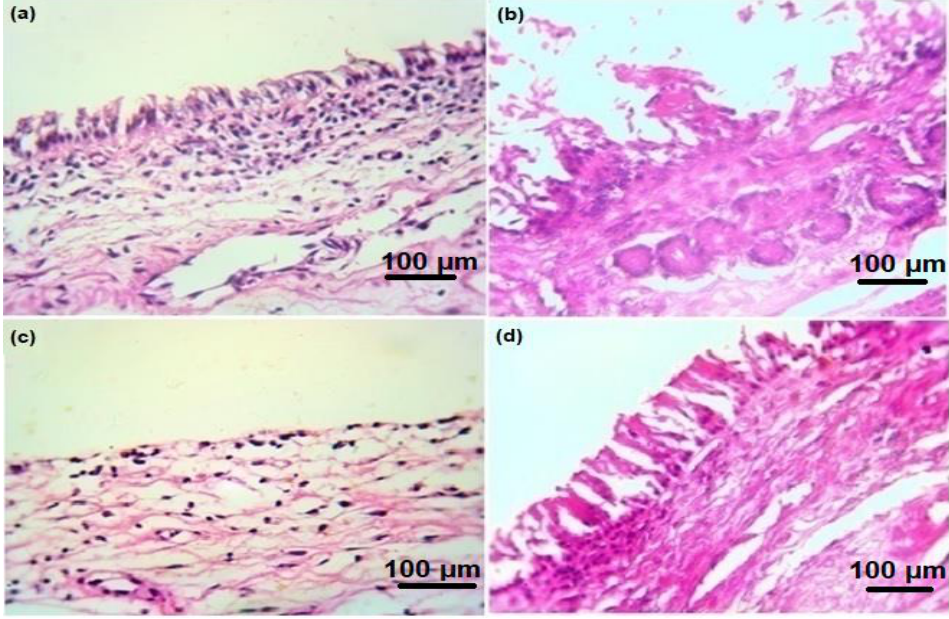
Figure 7. Histopathological images of goat nasal mucosa ( a ) PBS (pH 6.4) negative control, ( b ) IPA positive control, ( c ) pure MEM (2 mg/mL), and ( d ) MEM-NC3 (2 mg/mL).